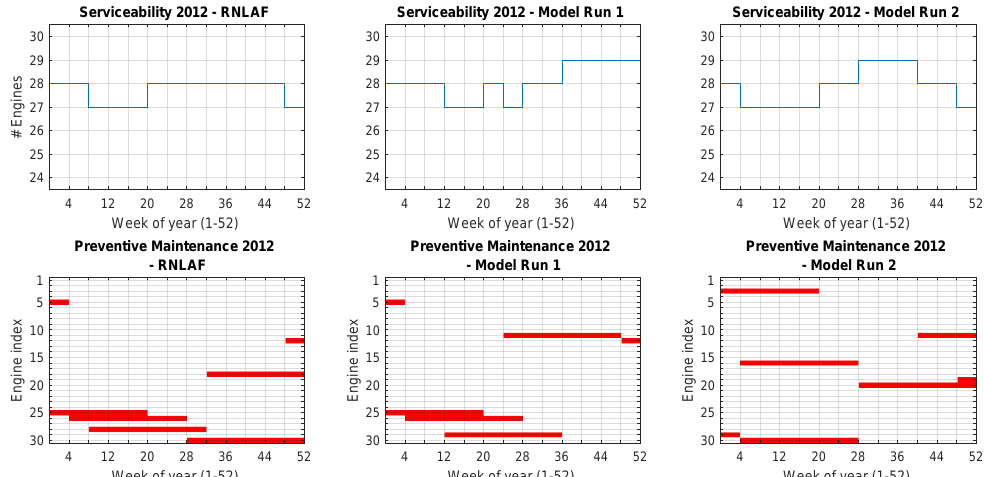
Figure 7. Results of the CMP optimization model with respect to serviceability and preventive maintenance schedule for the year 2012. Simulated RNLAF results (left) are presented alongside the output of two model runs for the same year (middle and